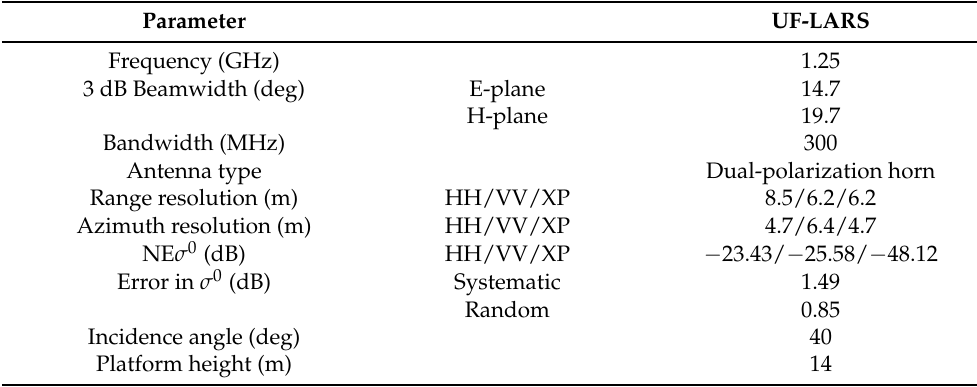
Table 2. UF-LARS system